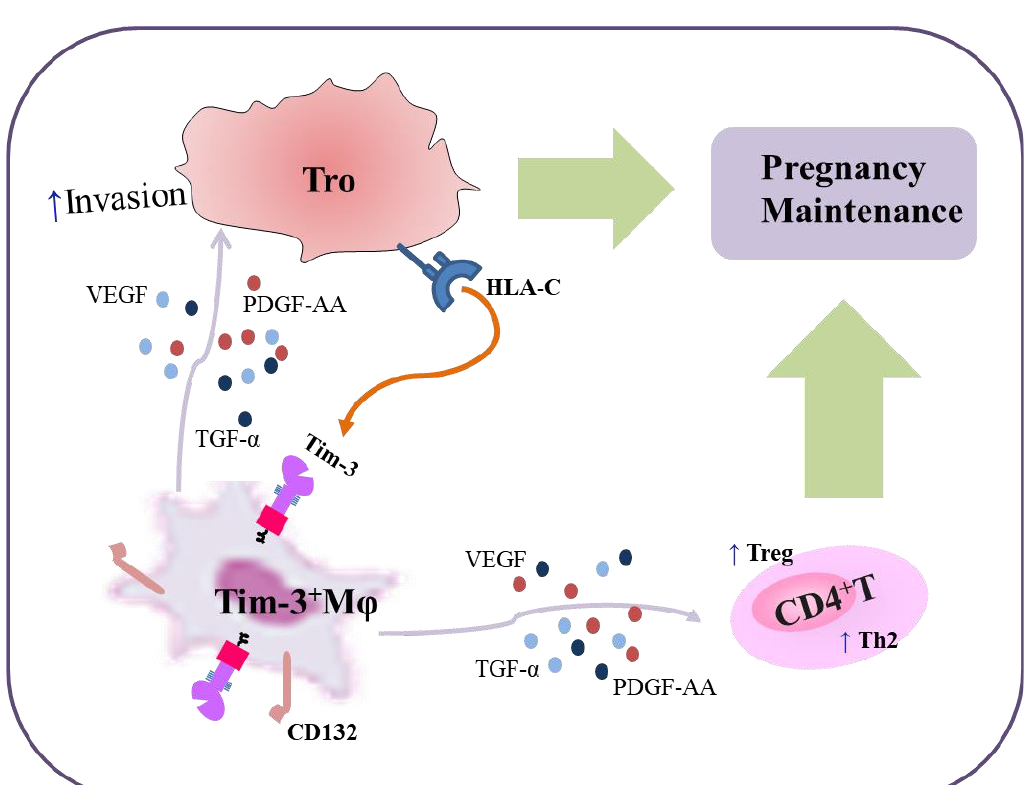
Figure 7. Schematic diagram of functional regulation of Tim-3 on M ϕ s-trophoblasts crosstalk during pregnancy. Previously, we reported EVTs induced the higher Tim-3 expression on dM ϕ s in normal pregnancy in an HLA-C-dependent manner. With higher expression of CD132, Tim-3 + dM ϕ s induced dCD4 + T cells toward Th2 and Treg bias and promoted pregnancy maintenance. The current study revealed that Tim-3 + dM ϕ s promoted invasion and tube formation ability of trophoblasts through AGFs (PDGF-AA, TGF- α , and VEGF). These AGFs derived from Tim-3 + dM ϕ s also helped to promote Th2 and Treg bias in dCD4 + T cells. The blockade of Tim-3 or AGFs resulted in placental dysplasia and dysfunction of maternal–fetal tolerance. While AGFs-treated Tim-3 − M ϕ s could also partially resolve the fetal resorption resulting from M ϕ depletion. Thus, Tim-3 not only promoted maternal–fetal tolerance but also improved EVT function through M ϕ s-EVTs interaction to promote pregnancy